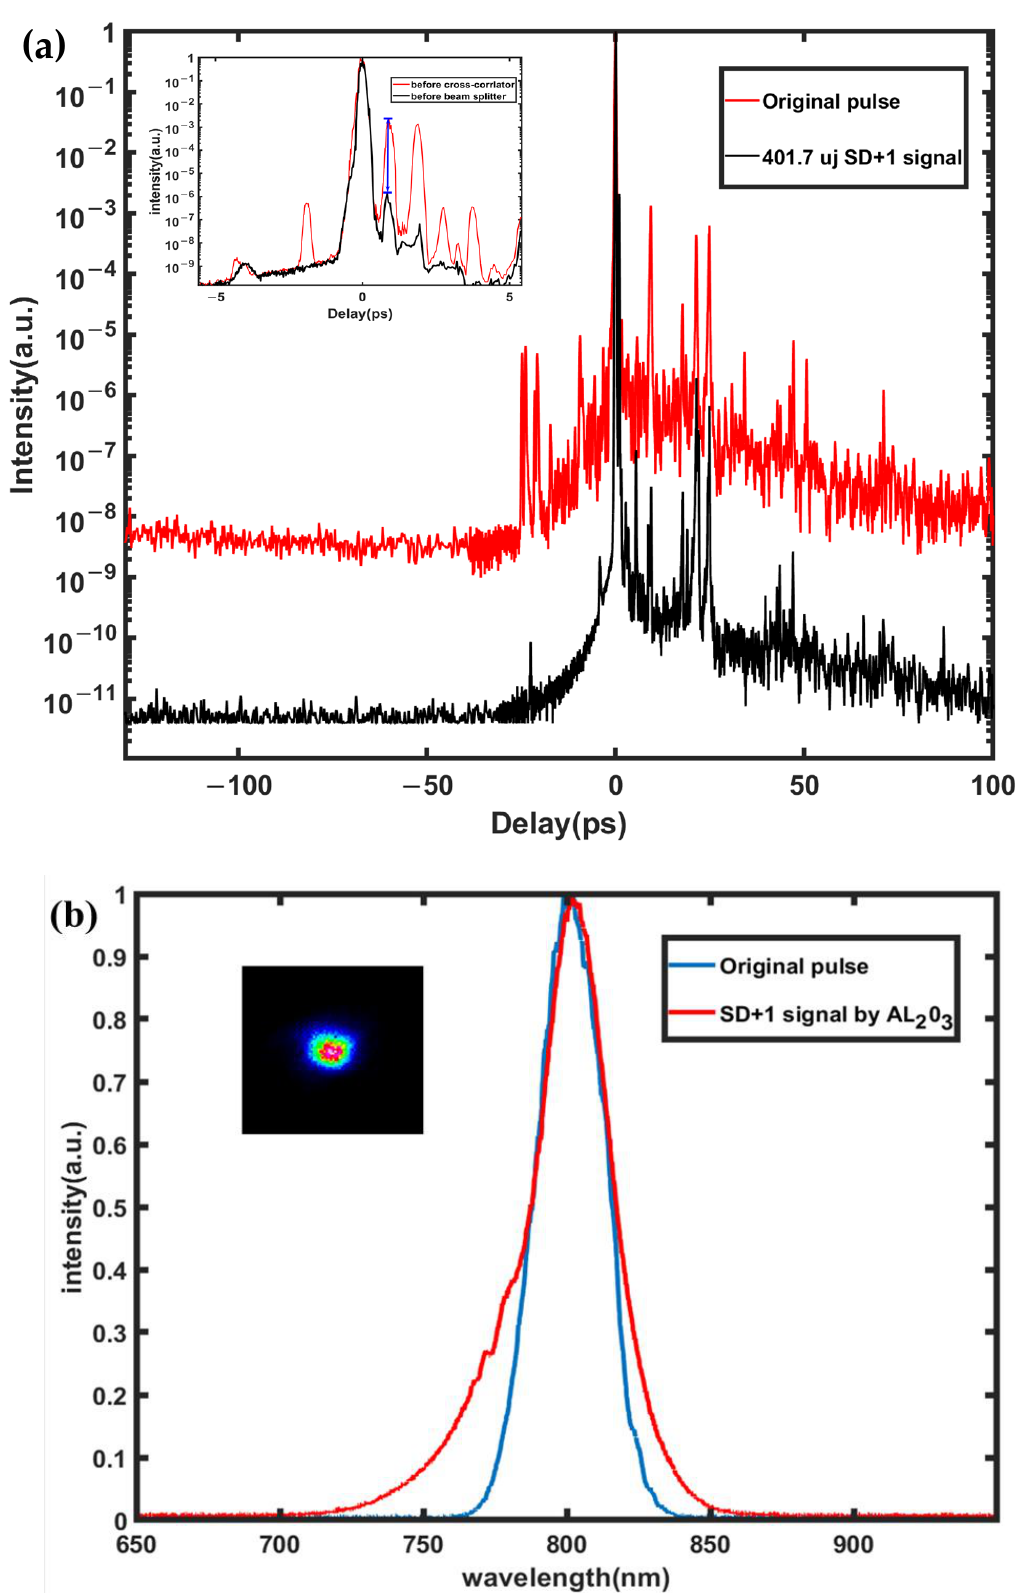
Figure 7. ( a ) Measured temporal contrast of the original pulse (black line) and the generated SD + 1 signal in the Al 2 O 3 plate with 401.7 μJ energy (red line). ( b ) Spatial profile of the SD1 signal and the spectra of the input laser pulse and SD1 pulse.